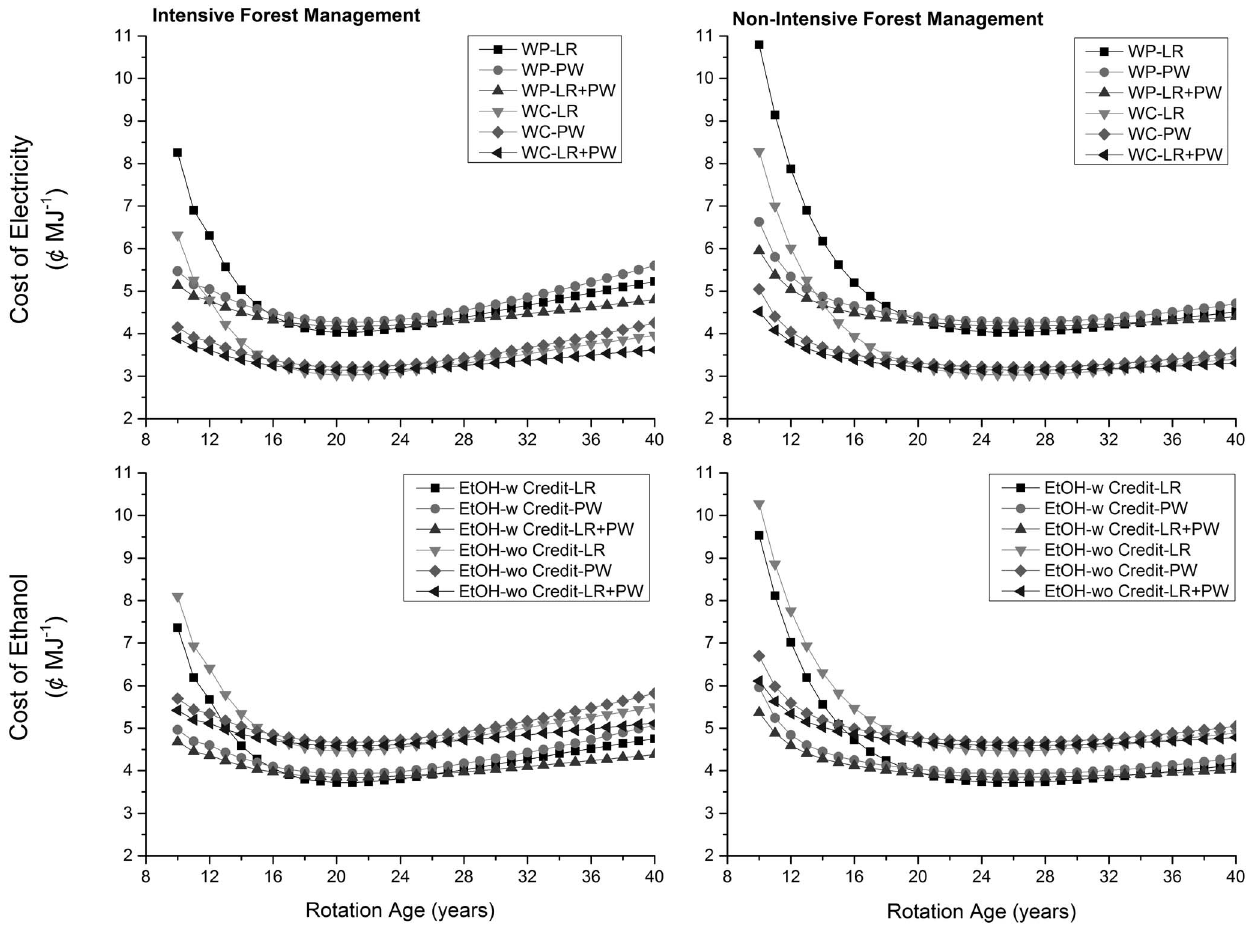
Figure 4. Cost of energy products at the production level. LR: logging residues; PW: pulpwood; WP: wood pellets; WC: wood chips; w: with income from cogenerated electricity; wo: without income from cogenerated electricity.